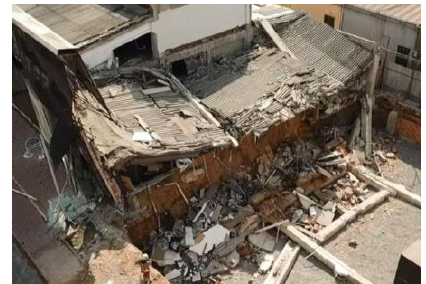
Figure 4. A picture of te collapsed building (source: DHA, from evrensel.net)